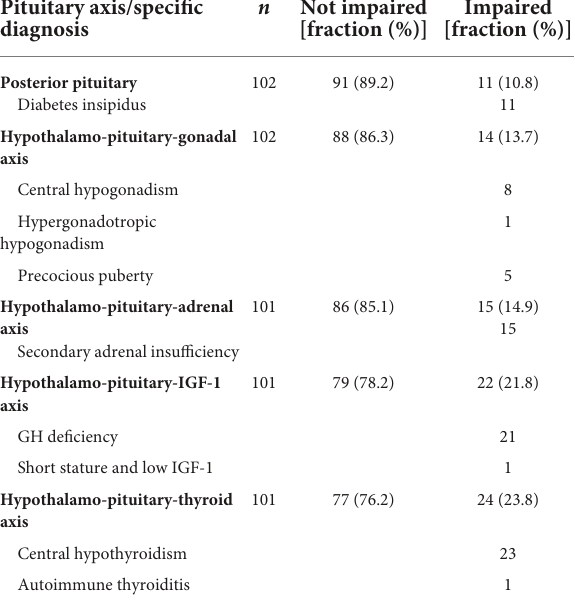
TABLE 4 Endocrine health as diagnosed at initial visit.